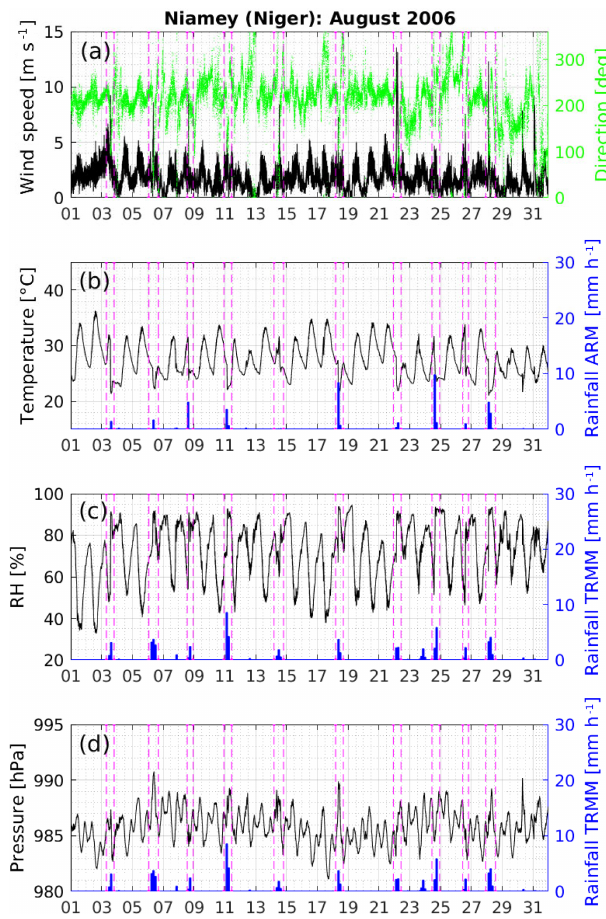
Figure 11. Surface meteorological data from the ARM Mobile Fa- cility with a 1min sampling interval (black or green lines) at Ni- amey during August 2006: (a) wind speed (ms − 1 ) and direction ( ◦ ), (b) temperature ( ◦ C), (c) relative humidity (%), and (d) pres- sure (hPa). The 3h rainfall (mmh − 1 ; blue bar plots) is retrieved (b) from the ARM Mobile Facility and (c, d) from the TRMM Mul- tisatellite Precipitation Analysis. Each MCSs detected is shown us- ing two dashed vertical dashed magenta lines indicating the start and end of the rainfall